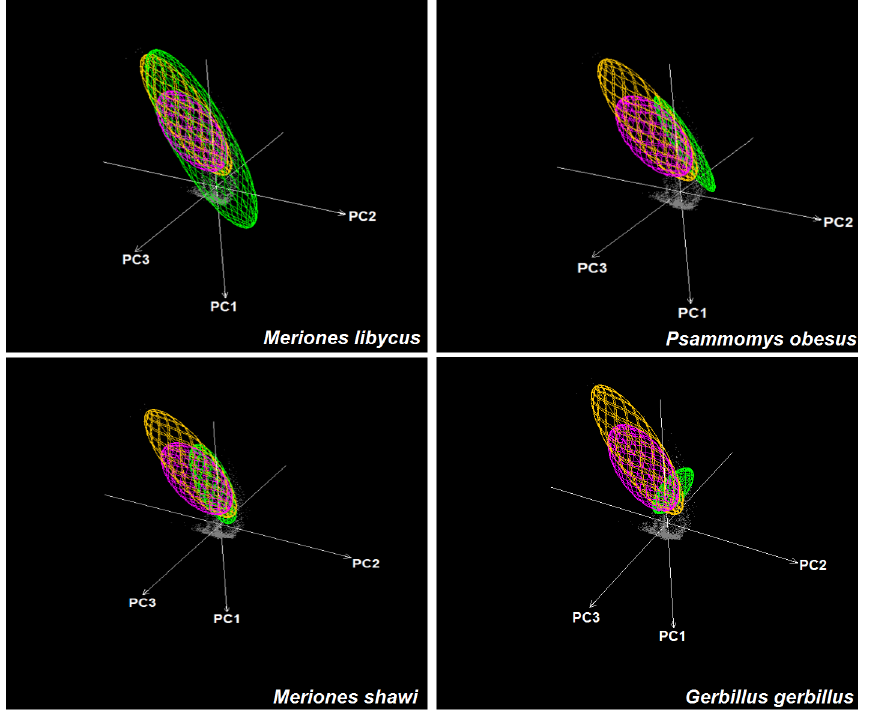
Fig 5. Visualization of ecological niches of Leishmania major , Phlebotomus papatasi , and animal reservoir in three environmental dimensions (PC1, PC2, and PC3). Niches are represented as minimum volume ellipsoids to illustrate the limits under which the species has been sampled. Gray shading represents environmental background, green ellipsoid represents the potential mammal reservoir, yellow is the vector Phlebotomus papatasi , and purple represents Leishmania major